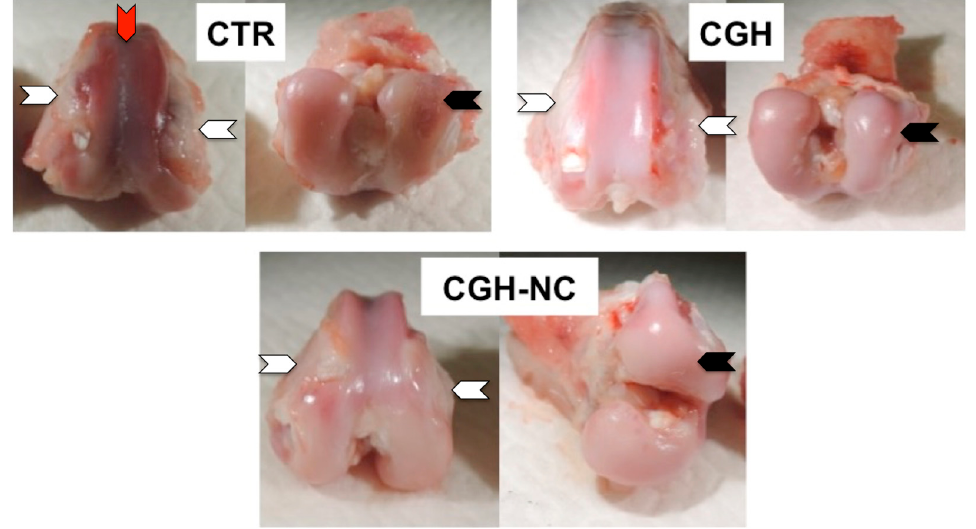
Figure 2. Macroscopic appearance of samples from the different study groups at 84 days. White arrows point to osteophytosis, black arrows point to ulcerations and the red arrow points to a cartilage eburnation.